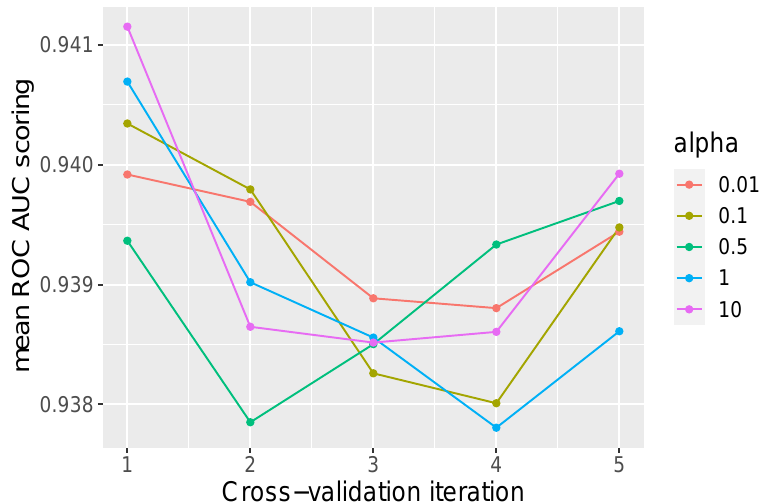
Figure 4. Naive Bayes mean scoring by